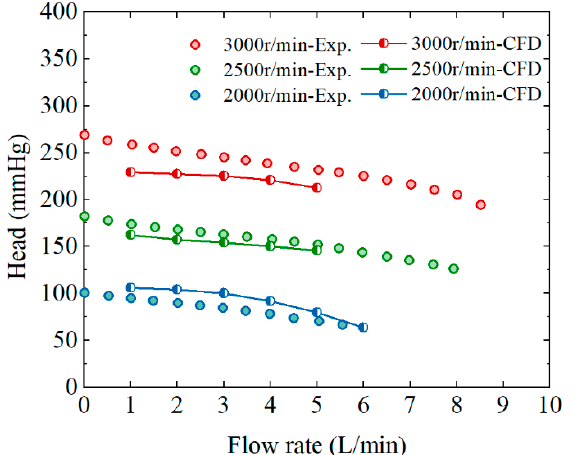
Figure 5. Experimental and simulation hydraulic performances of the original pump model No. 4.